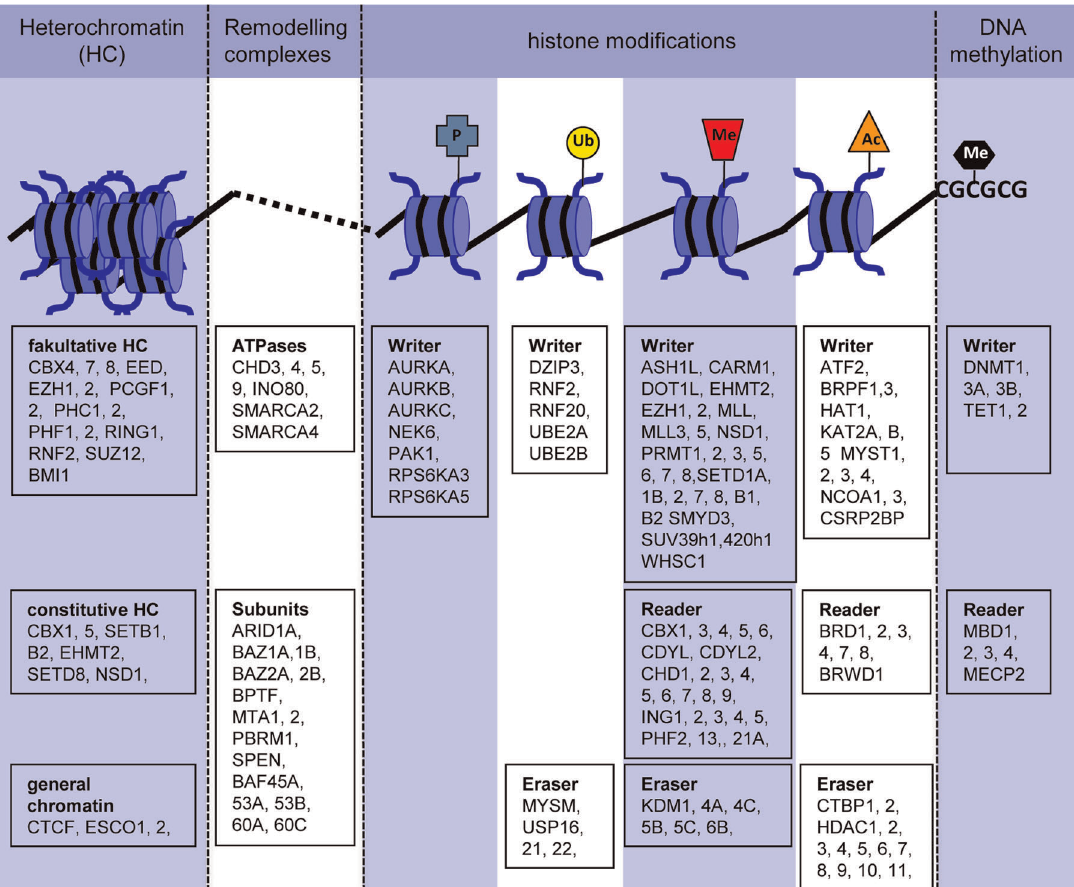
Figure 2. Compilation of 150 representative genes involved in epigenetic regulation. The genes were identified, selected, and classified according to their function based on published literature and database searches. In a further step, the genes related to histone modifications were sub-classified as writers (coding for modifying enzymes such as methyltransferases), as erasers (coding for de-modifying enzymes such as histone deacetylases) and as readers (coding for proteins that bind to the respective modification).